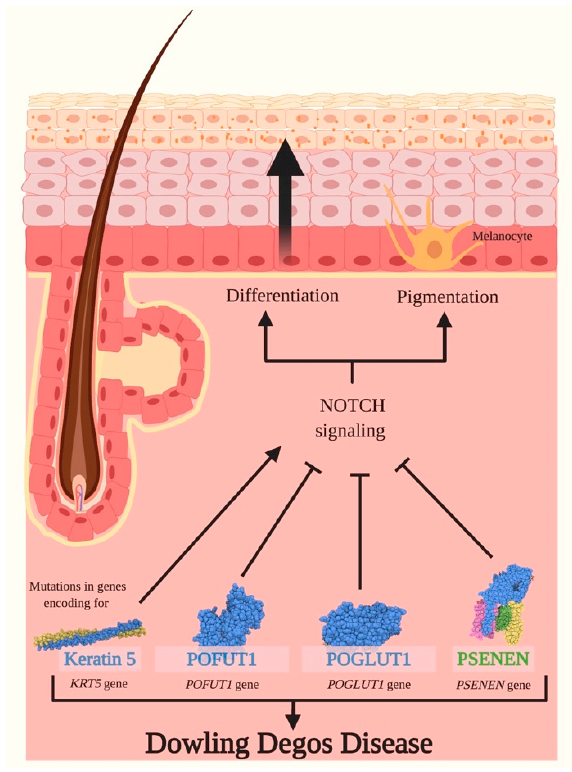
Figure 6. Dowling Degos Diseases and Notch signaling. Dowling Degos Disease (DDD) is a rare skin genodermatosis characterized by hyperkeratotic papules and reticulate hyperpigmentation. Classical DDD is induced by mutations in KRT5 gene encoding for keratin 5, and the latter is a fundamental protein required for the synthesis of intermediate filaments, principally in the epidermal cells of the stratum basale. The loss of expression of KRT5 during epidermal di ff erentiation seems to be linked to an activation of Notch signaling, therefore negatively impacting epithelial remodeling. Other genes involved in DDD are POFUT1 , POGLUT1 and PSENEN , encoding for GDP-fucose protein O-fucosyltransferase 1 (POFUT1), Protein O-glucosyltransferase 1 (POGLUT1) and presenilin enhancer protein 2 (PSENEN), respectively. POFUT1 mutations lead to nonsense-mediated decay of the transcript, to impaired Notch signaling and to an abnormal pigmentation of the skin. Mutations in POGLUT1 gene presumably cause a nonsense-mediated decay of mRNA resulting in haploinsu ffi ciency, in a blockade of the Notch pathway and in promoting cell di ff erentiation. Pathogenic PSENEN variants impair Notch signaling and cause an aberrant di ff erentiation and pigmentation of the epidermis, leading to reticulate pigmentation, comedones, follicular hyperkeratosis, nodules and scars. Pointed arrows ( → ) define the induction of the indicated process or associated function, while the truncated arrow (T) designates the inhibition of the described process.